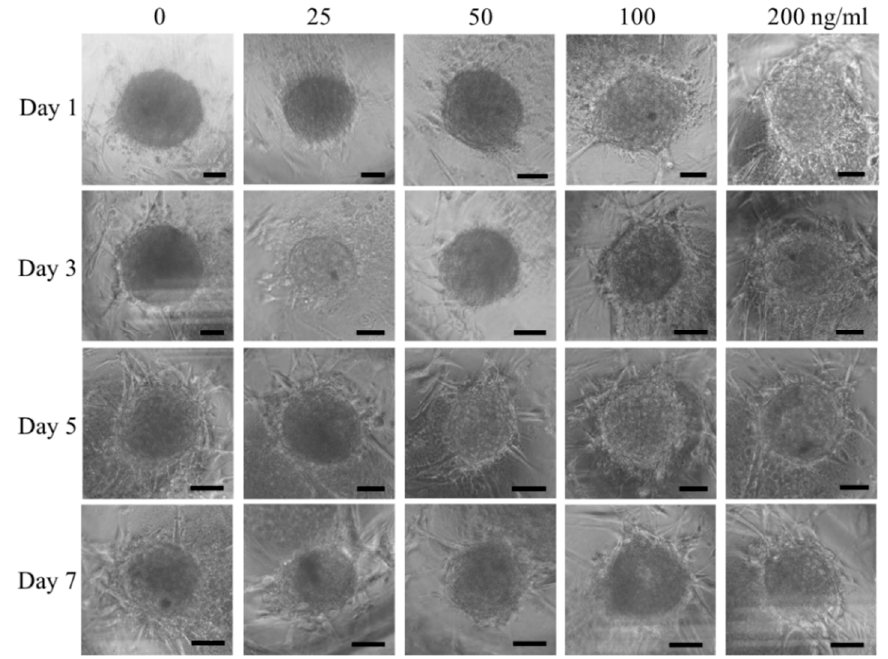
Figure 2. The morphologies of stem cell spheroids treated with different concentrations of CTGF on Days 1, 3, 5, and 7. The scale bar represents 200 µ m (original magnification × 100). No significant changes were seen in the morphology of cell spheroids with addition of CTGF.